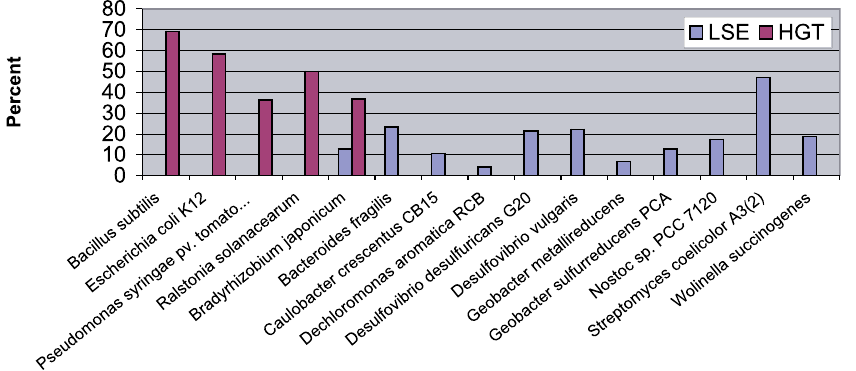
Figure 7. Extent of Domain Shuffling in Different Classes of HPKs The fraction of HPKs with identical upstream domains to either their inferred HGT partners (red bars), or to their closest paralog (blue bars) in the case of LSE. Only genes that are not believed to have undergone duplication within a lineage are used in the HGT group. B. japonicum , which has a significant number of genes classified as HGT and LSE, is shown twice. doi:10.1371/journal.pcbi.0020143.g007 PLoS Computational Biology |